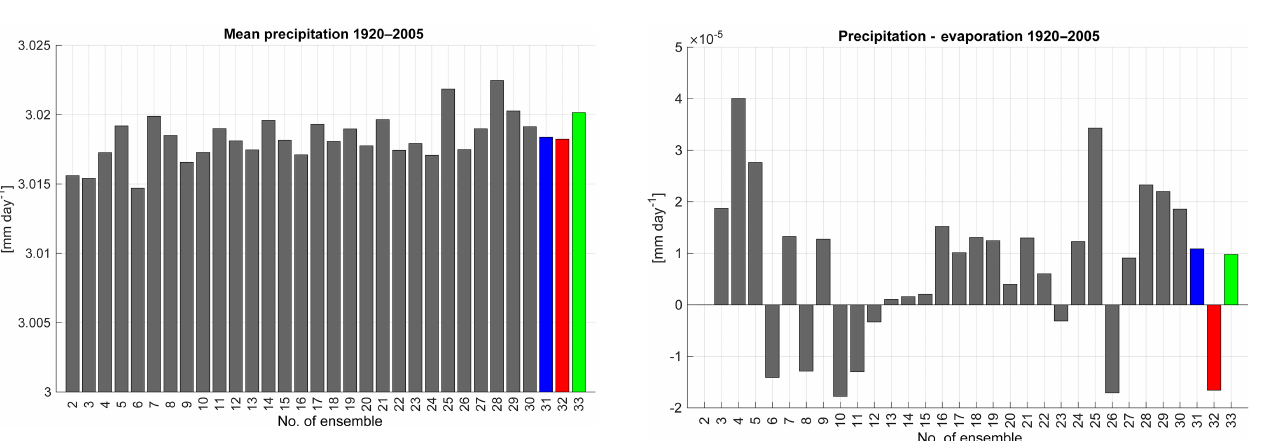
Figure 10. The balance between precipitation and evaporation from 1920 to 2005 for CESM-LE members 2–30 and new members 31– 33 with adjusted compression level for LHFLX ( fpzip -24). Note the difference in scale between this plot and that in Fig. 9. Also, mem- bers 31 and 33 have been subjected to lossy